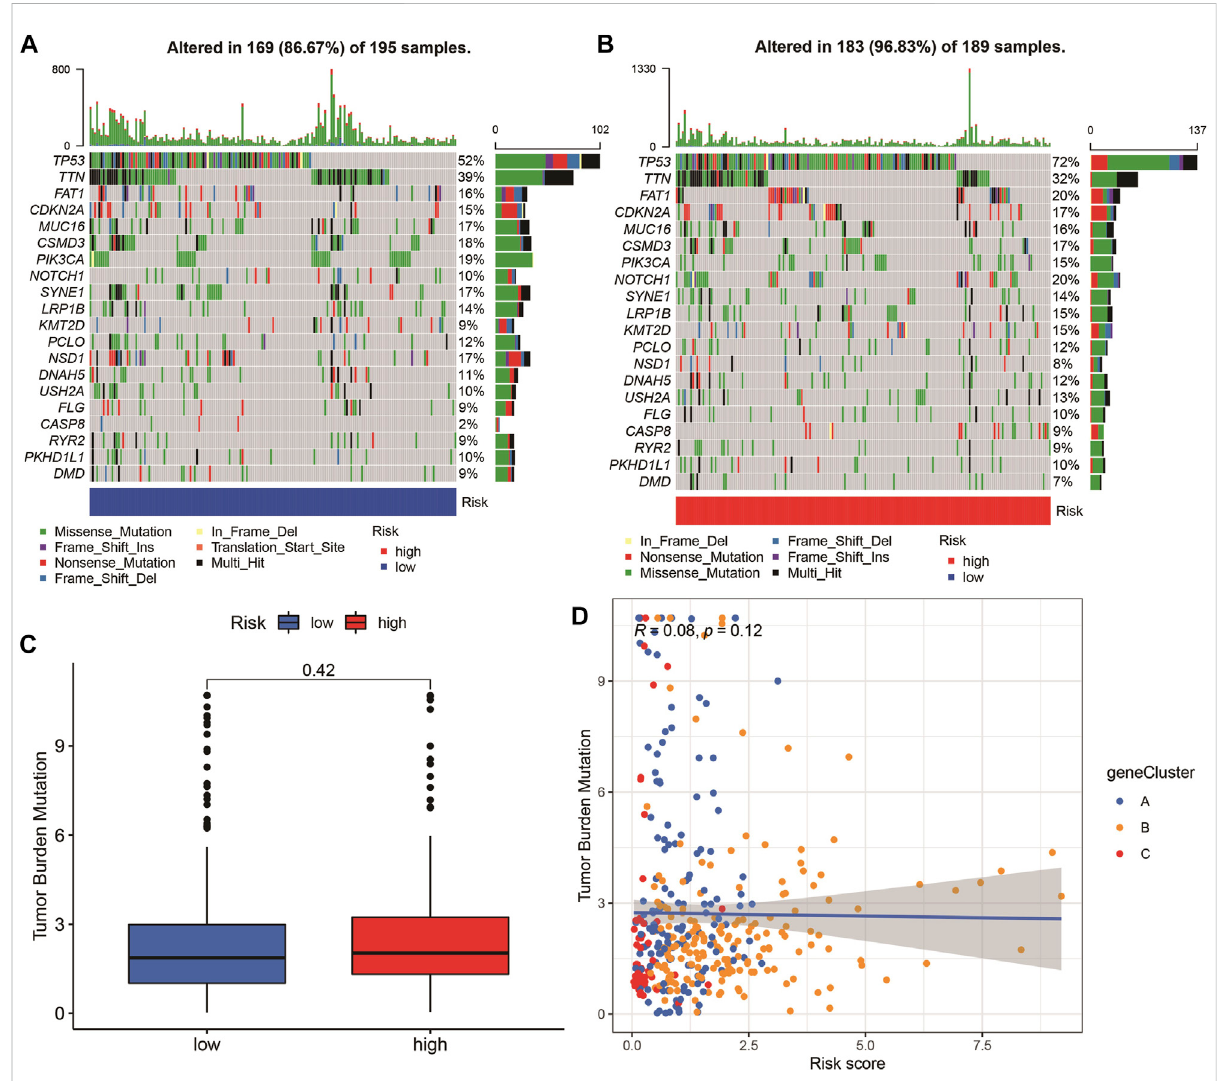
FIGURE 13 Tumor mutation burden (TMB) analyses. (A – B) The top 20 driver genes with the highest mutation frequencies in high and low pyroptosis score groups (C) Boxplot illustrates that TBM value in the high-risk group was not signi fi cantly higher ( p = 0:42). (D) Scatter plots of correlation analysis of risk score and TBM